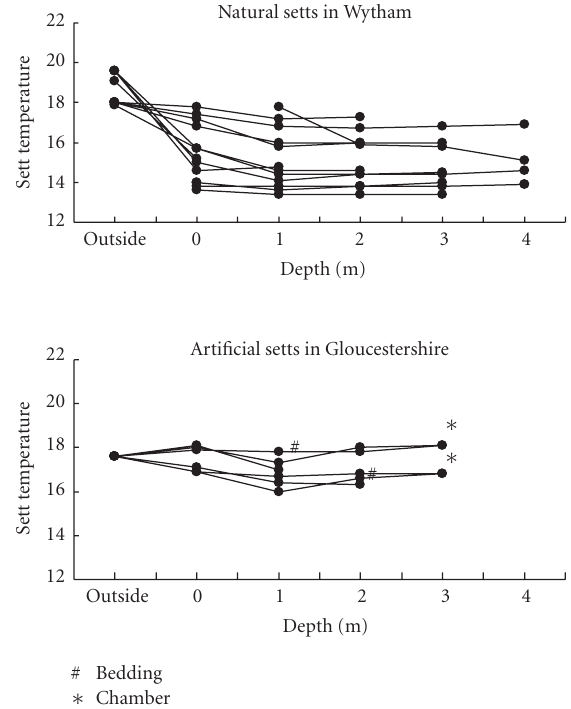
Figure 2: External and internal sett temperature at each meter depth from the entrance: four main natural setts in Wytham upper, June and July 2003 and two artificial setts in Gloucestershire (below, July